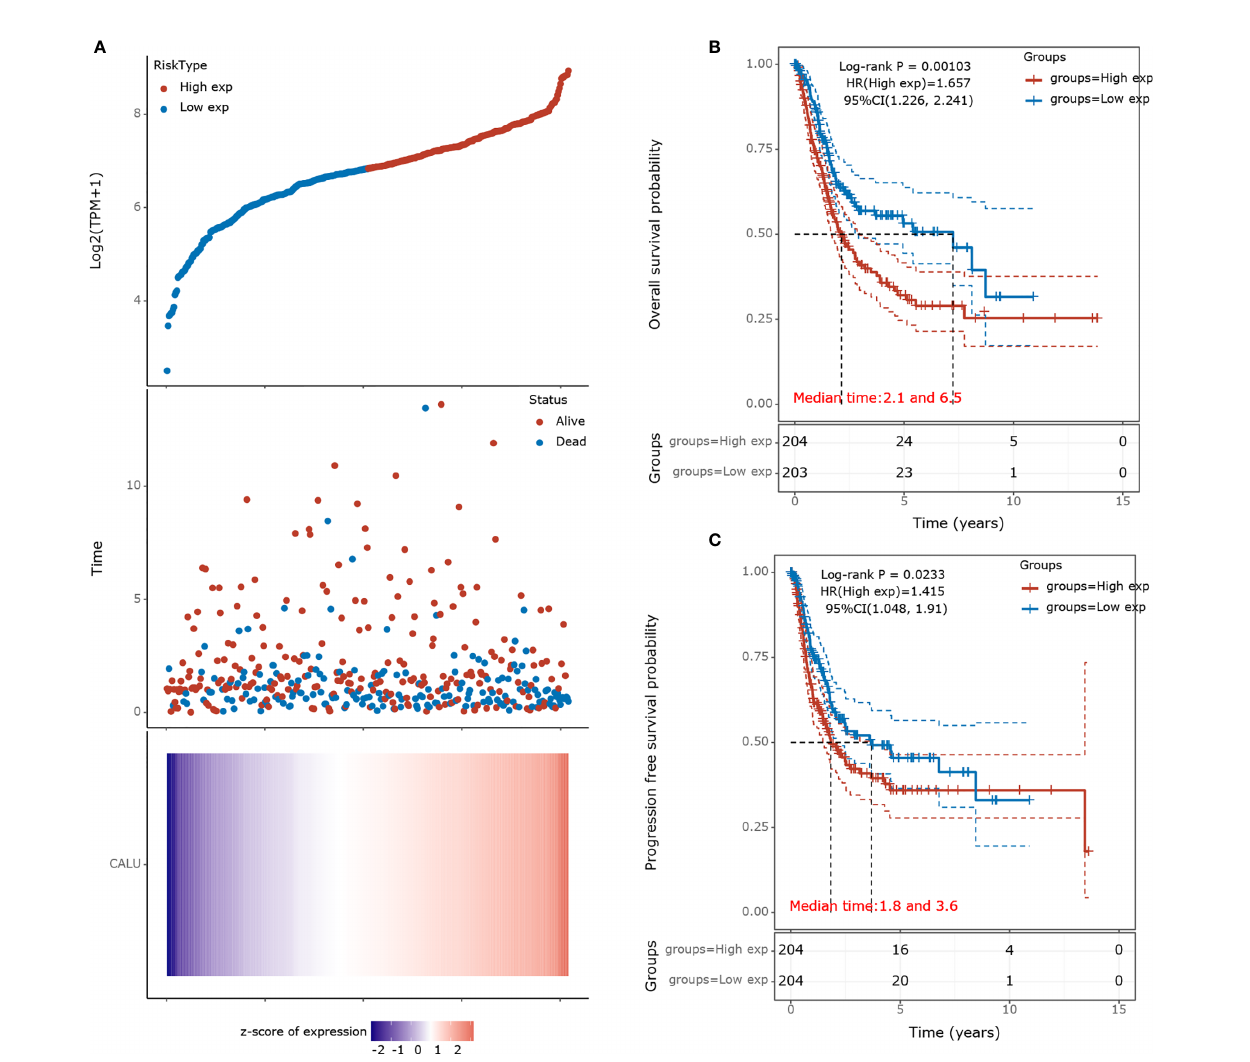
FIGURE 1 | Prognostic analysis of CALU in the TCGA BLCA cohort. (A) A scatterplot of CALU expression from low to high was placed in the upper portion. The middle represents the scatter plot distribution of survival time and survival status corresponding to different patients ’ CALU expression. The heatmap of CALU expression in all patients was shown at the bottom. (B) Kaplan-Meier survival analysis validated CALU as an adverse factor for the OS in BLCA (p=0.001, HR=1.657). (C) CALU also played a signi fi cant role in affecting the PFS of BLCA patients (p=0.023,